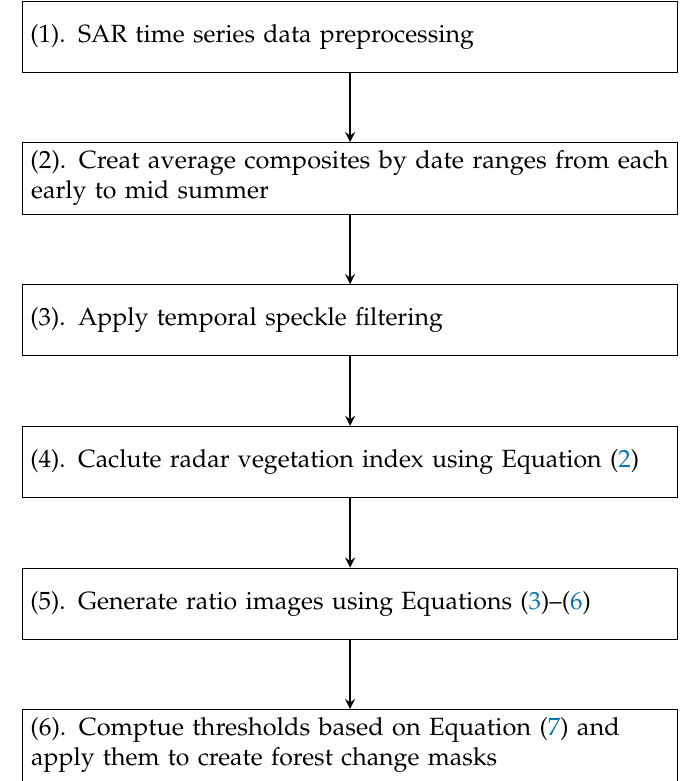
Figure 6. Flowchart of the forest change mapping steps applied to Sentinel-1 synthetic aperture radar (SAR) data.The data pre-processing step had been conducted by Google. The other steps were performed in the Google Earth Engine (GEE) platform. Reproducible code information for this work has been provided in the Supplementary Materials.